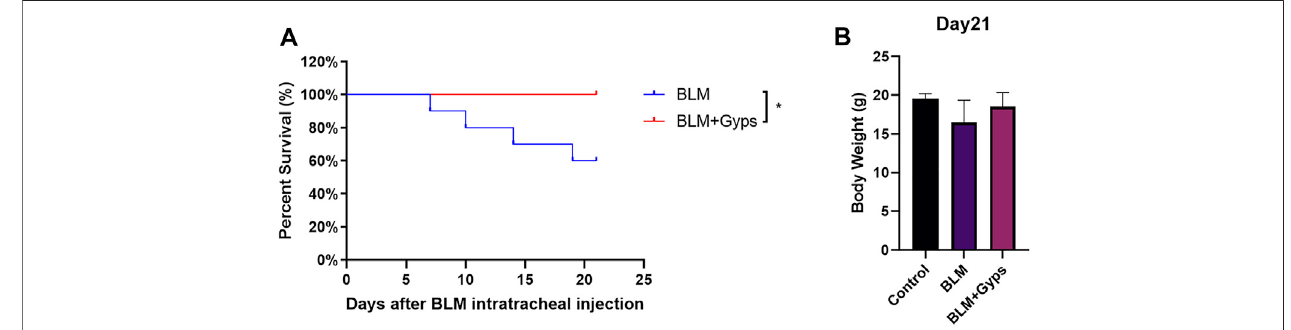
FIGURE2| Effects ofGypson PFdevelopmentinducedbyBLMinmice. (A) Survivalcurvesofmice ineach group.( n (cid:1) 10).ThePFmouse modelwasestablished on day 0. (B) Mouse body weights were measured on day 21. Gyps (cid:1) gypenosides, BLM (cid:1)